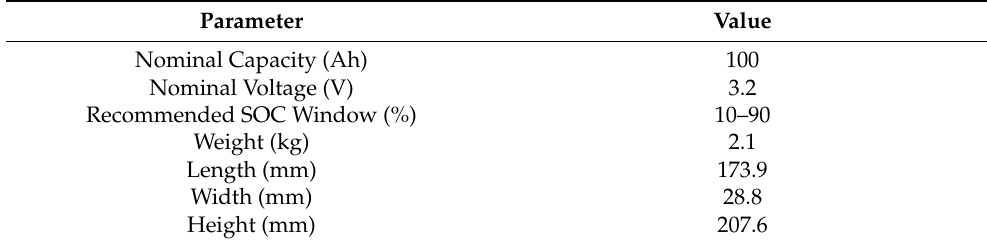
Table 3. Characteristics of the cell under study.